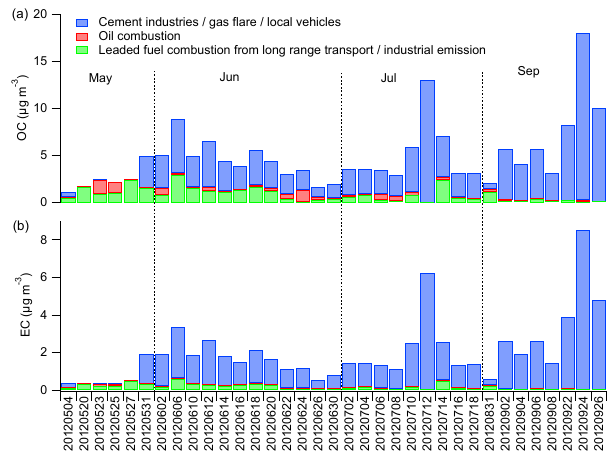
Figure 11. Source contributions to (a) OC and (b) EC (µgm − 3 ) from three sources for each